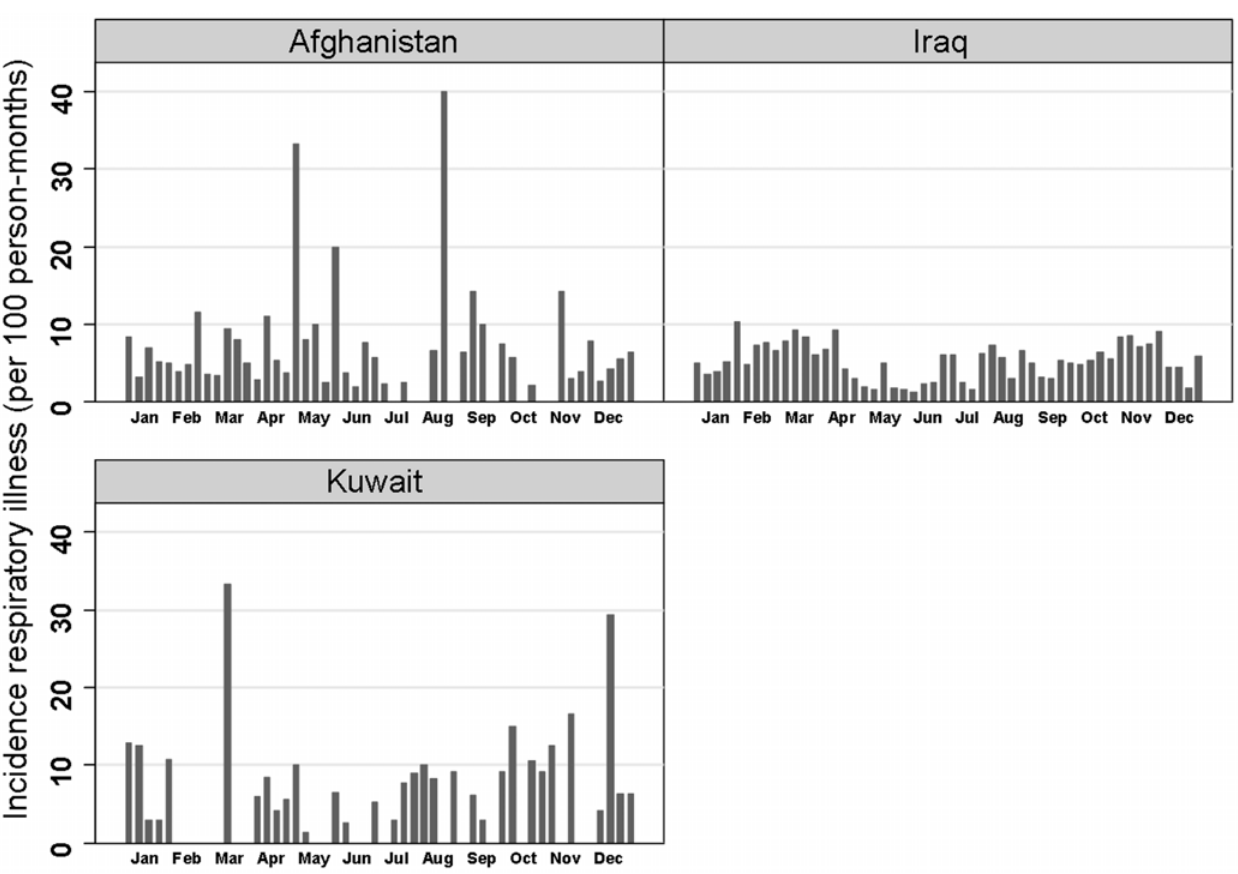
Figure 1. Probability of respiratory illness among U.S military personnel deployed in support of OIF/OEF by country of operation.